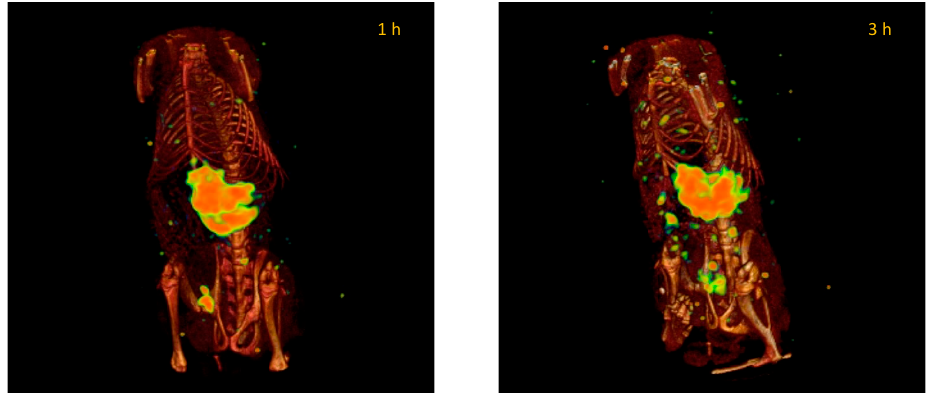
Figure 9. Representative SPECT/CT images of the 99m TcO 4 − biodistribution in healthy rats at 1 and 3 h after injection. The accumulation mainly occurs in the stomach. Images are from the same rat.